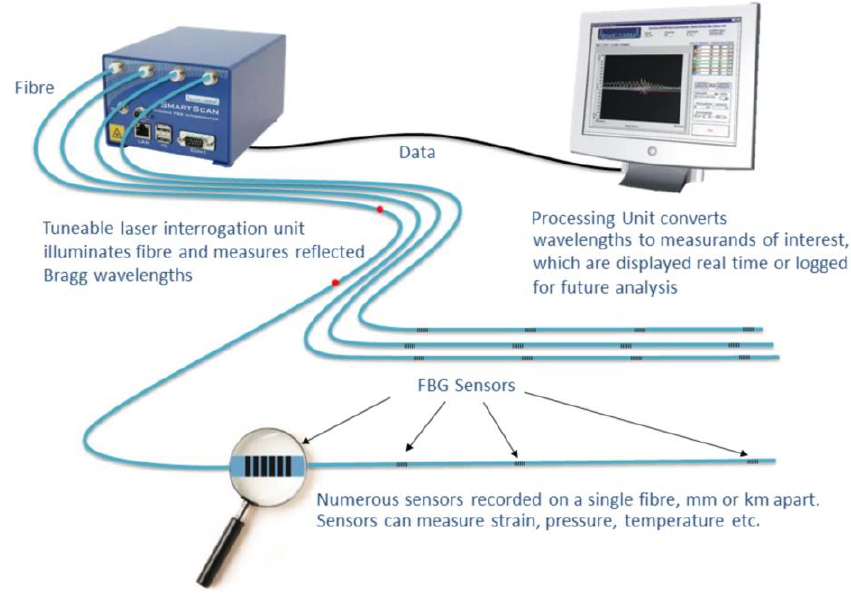
Figure 2. Measurement scheme of the FBG sensors.